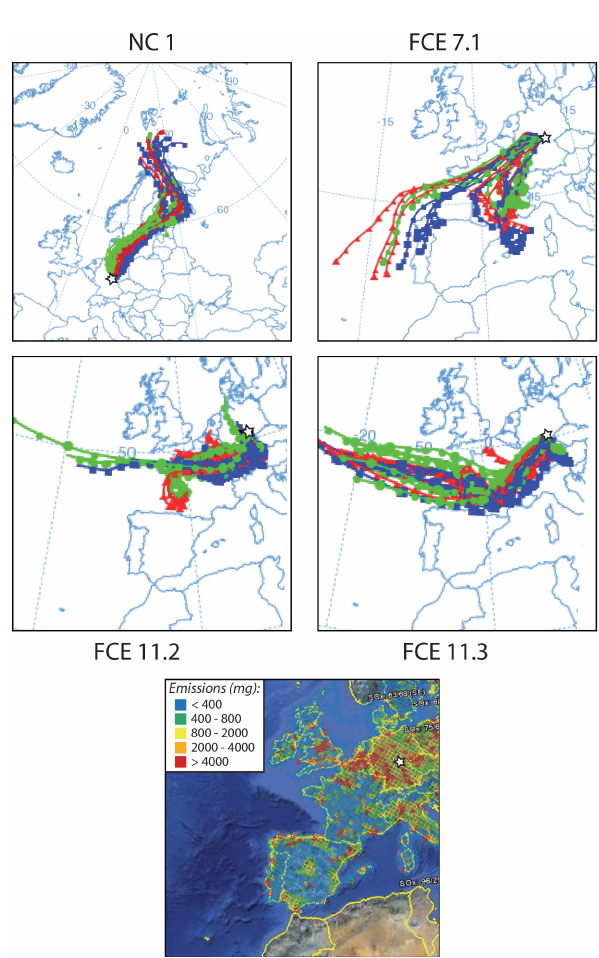
Fig. 1. Air mass back trajectories for cloud events at the HCCT- 2010 campaign. Emissions are in Mg (10 6 g) and are from the Cen- tre on Emission Inventories and Projections (CEIP,